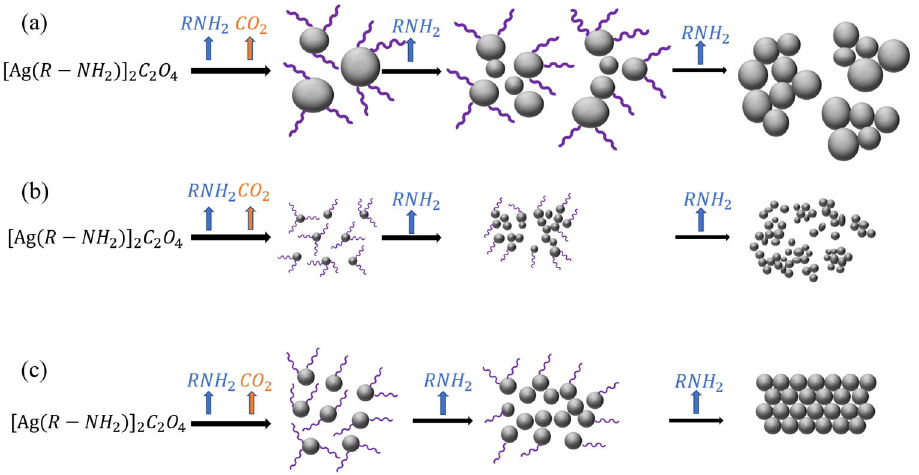
Figure 7. Decomposition mechanisms of different MODs: ( a ) MOD1, MOD6; ( b ) MOD2, MOD3, MOD7; ( c ) MOD4, MOD5.